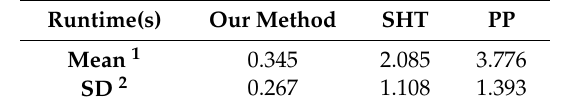
Table 6. Mean and standard deviation of computational time (in seconds) using our proposed method when compared with the other methods.